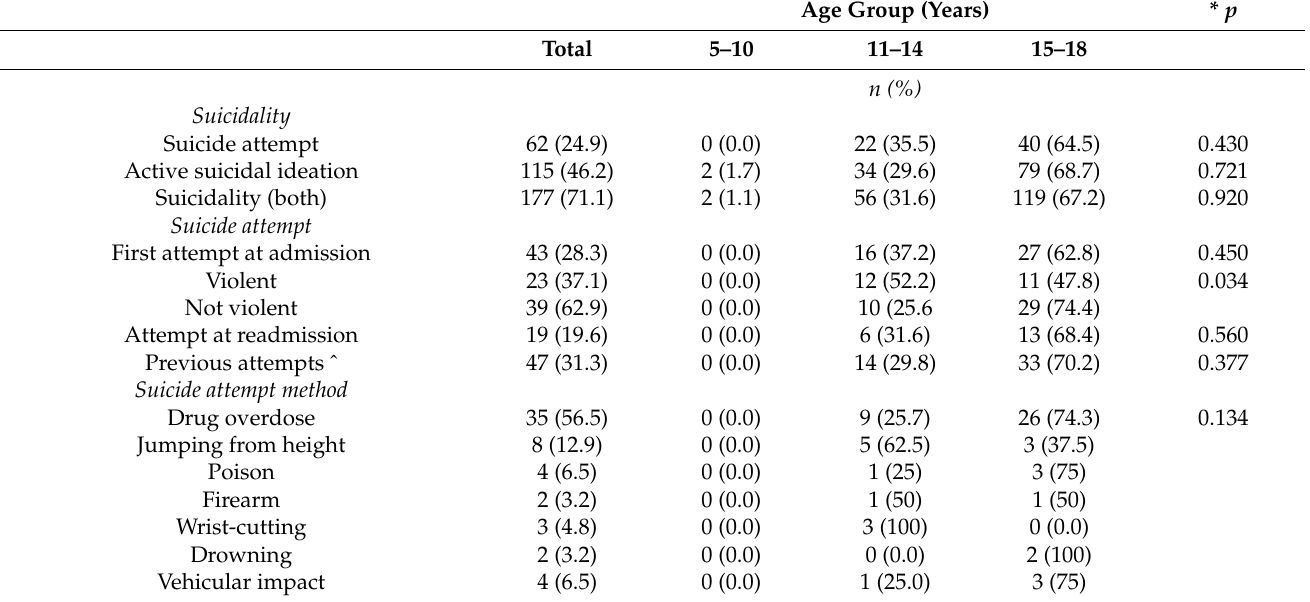
Table 3. Suicidality, suicidal ideation, suicide attempts, and methods (all